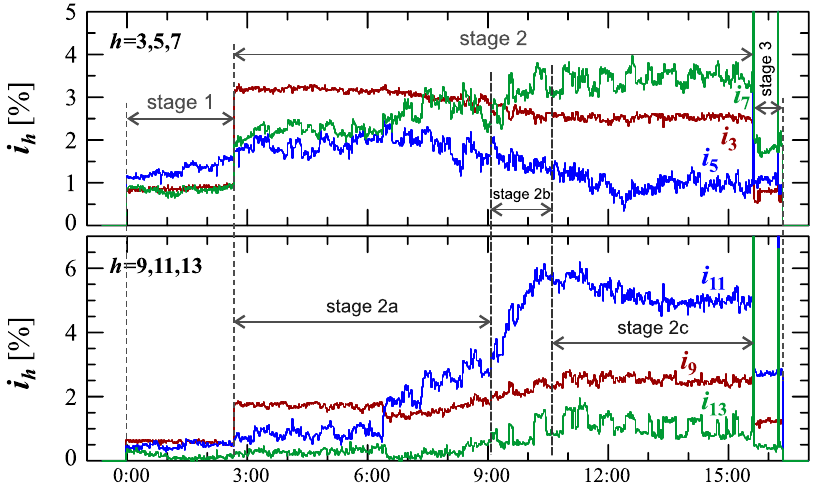
Figure 38. The characteristics of odd harmonics of the current i h = f ( t ) from the order h = 3 to 13 for Case